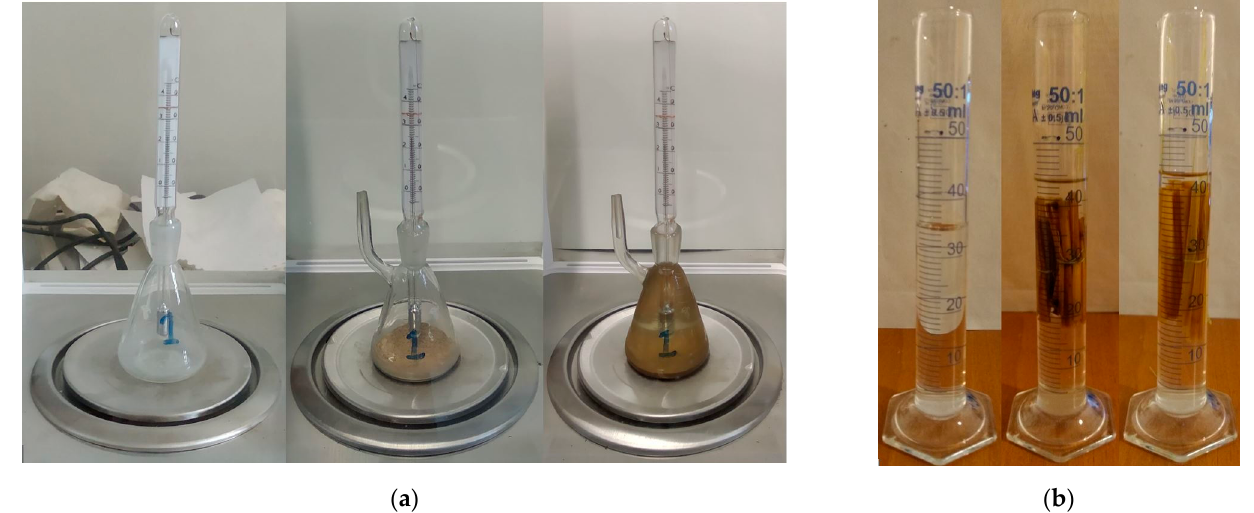
Figure 4. ( a ) Material density measurement with pycnometer, from left to right: empty pycnometer, straw dust added, straw dust and isopropyl alcohol added; ( b ) straw stem density measured with Archimedes method, from left to right: distilled water, Type-1 immersed, Type-2 immersed.